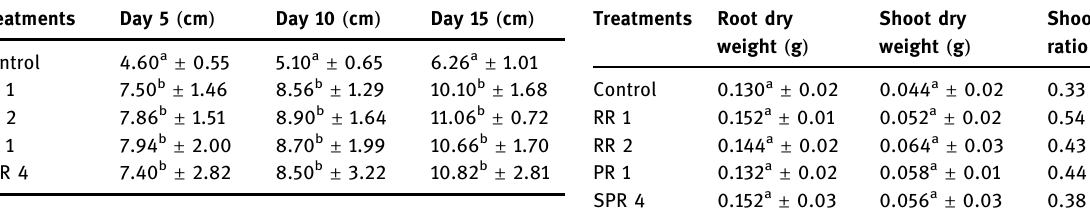
Table 5: E ff ect of PSB on dry weight of maize and shoot root ratio Treatments Root dry Shoot dry Shoot root weight ( g ) weight ( g )